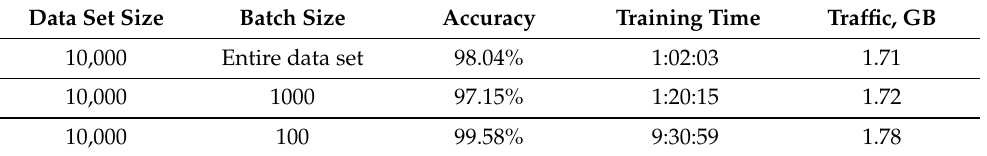
Table 4. Parameters of NN training using additive HE scheme for different settings. Data Set